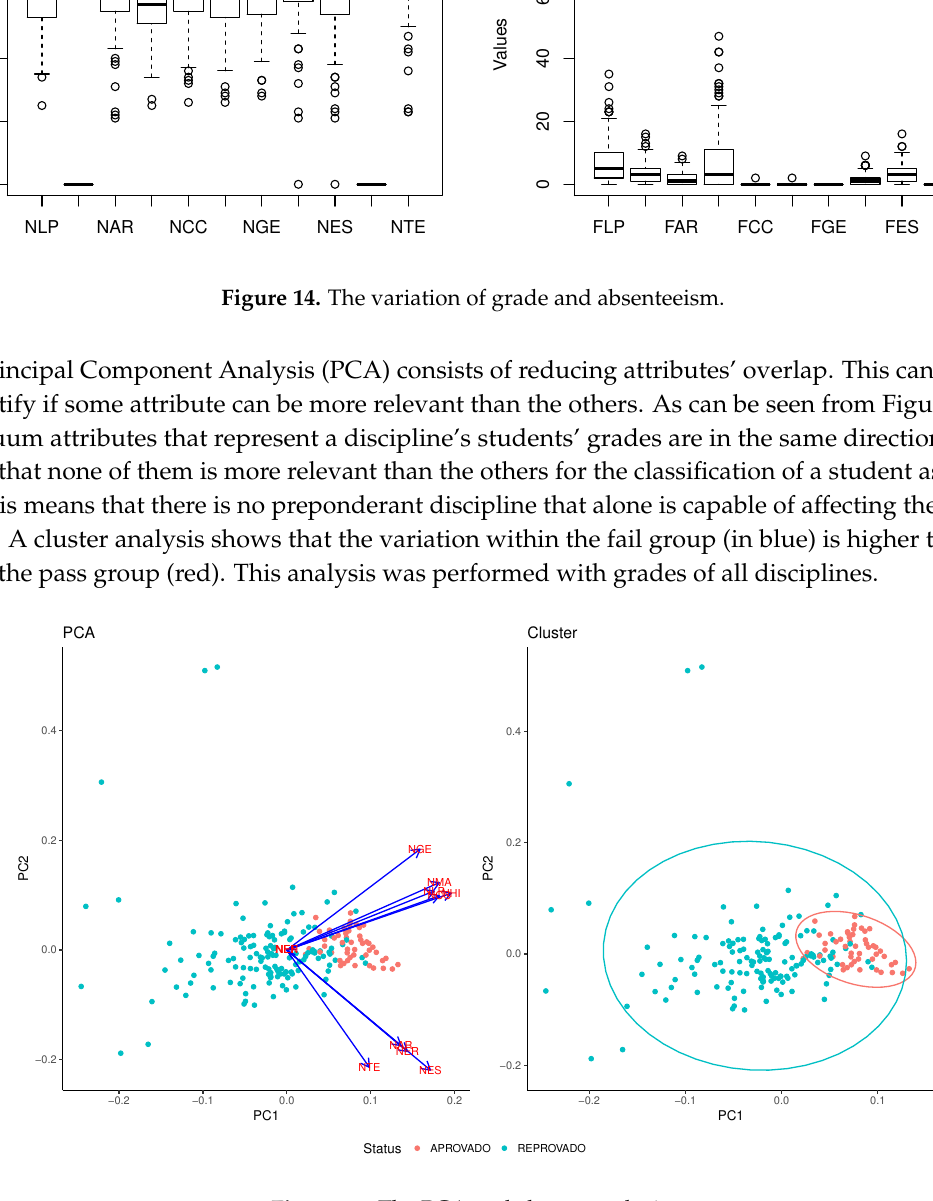
Figure 15. The PCA and cluster